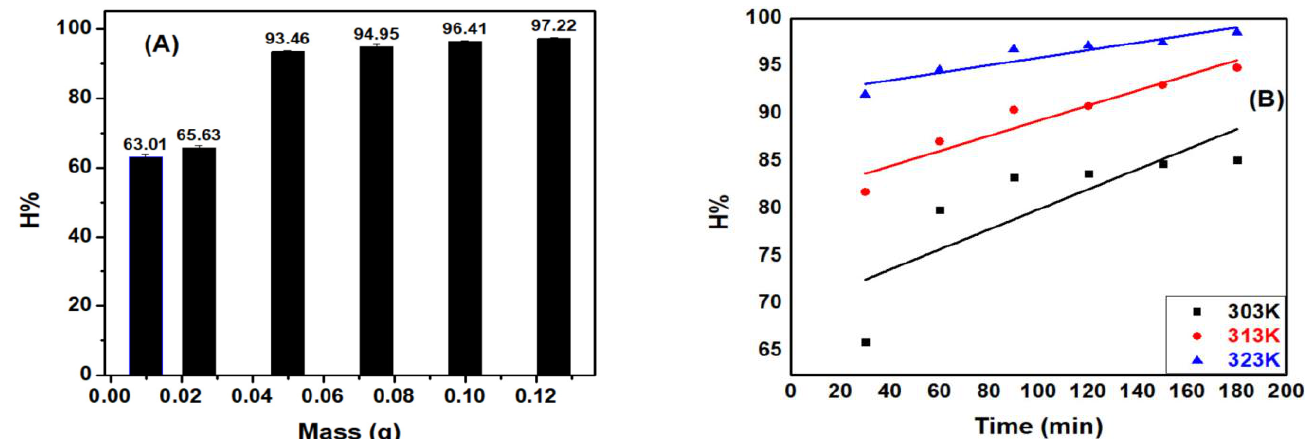
Figure 7. The effects of ( A ) ACDS mass on MB adsorption efficiency correlated with temperature ( B ).